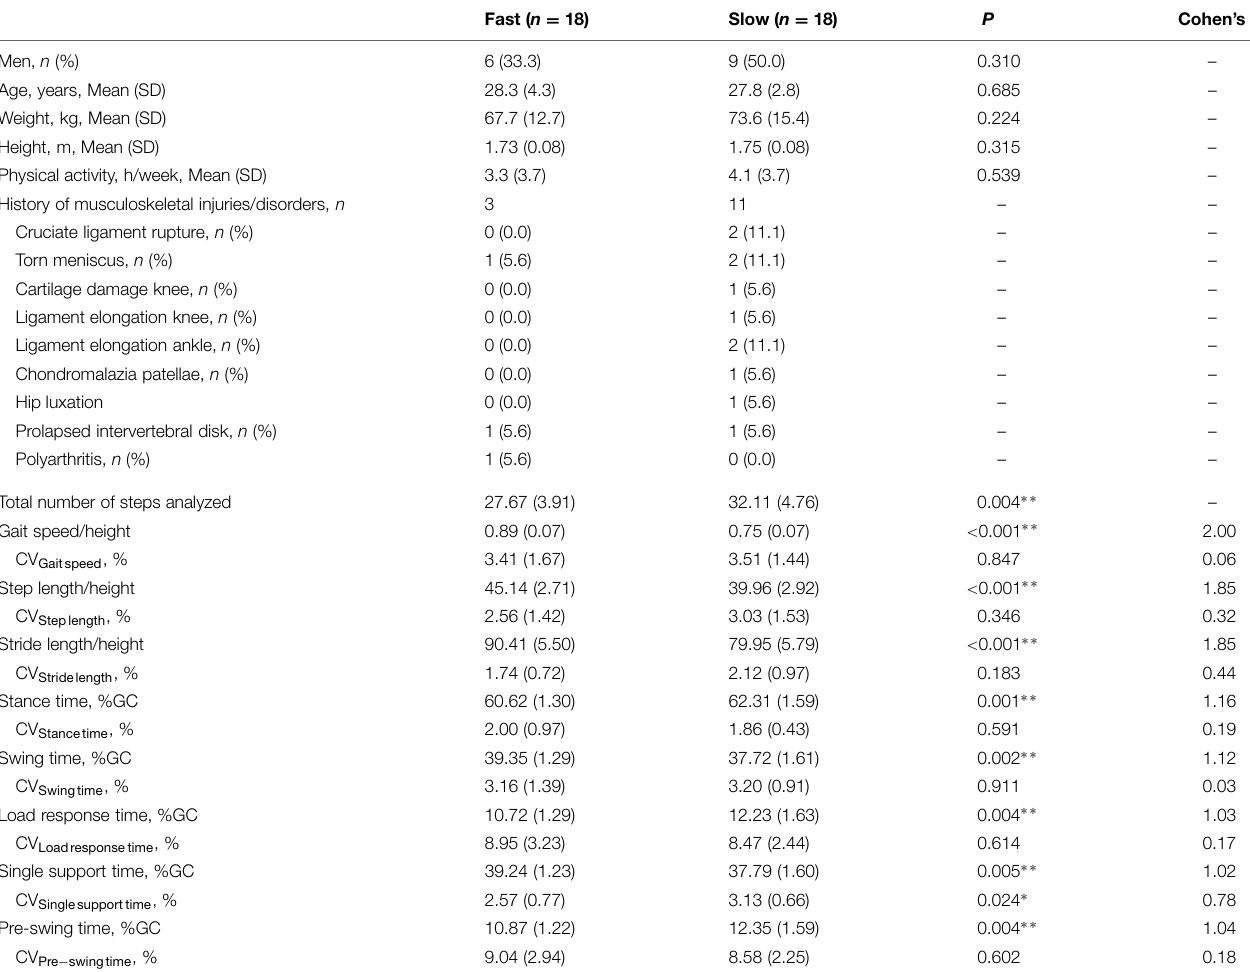
TABLE 1 | Experiment 1 – Demographic and clinical subject characteristics as well as and spatio-temporal and temporophasic gait parameters of slow- and fast-walking young